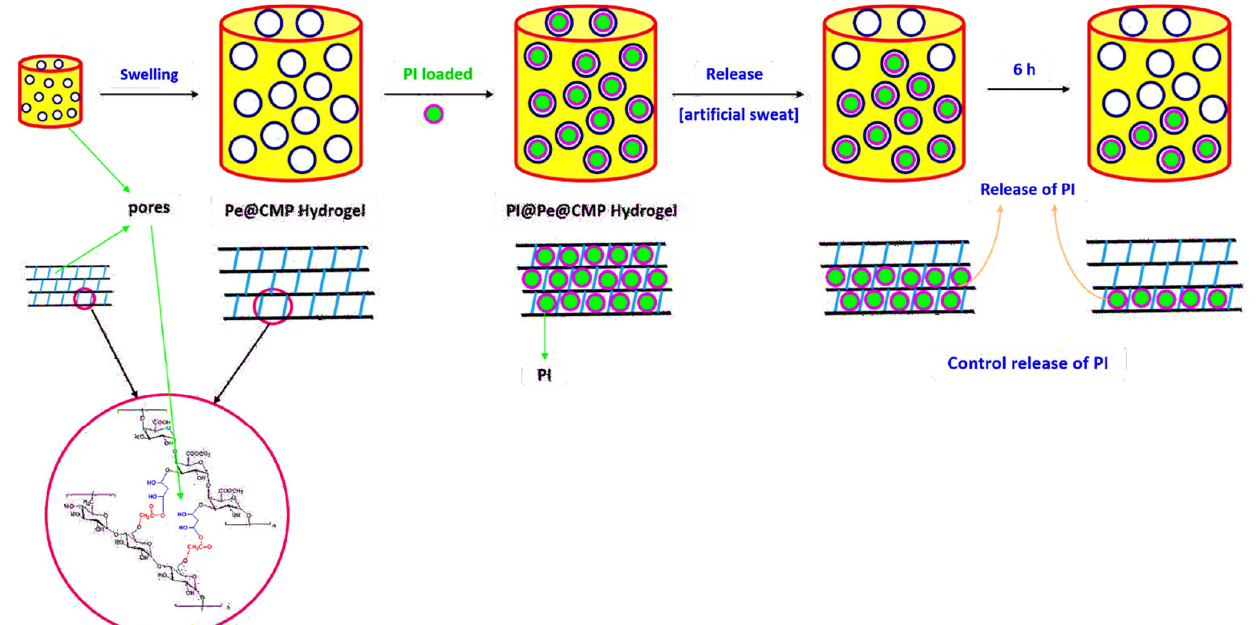
Figure 9. Physical releasing mechanism of PI from Pe@CMP hydrogel.